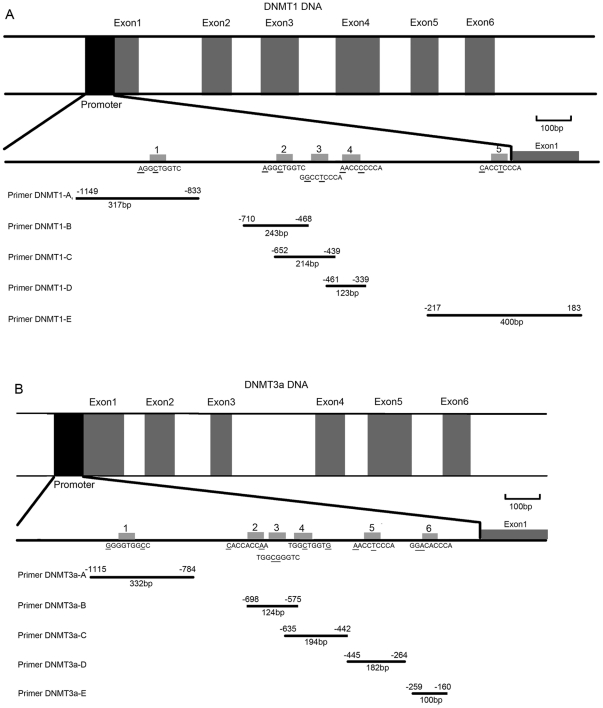
Potential GLI1 binding sites on the DNMT1's and DNMT3a's promoter.Two parallel lines on top of the figure represented DNMT1 or DNMT3a DNA, respectively(A, B), within which gray frames represented exons, white frames represented introns, and black frames represented promoter. In the promoter, small gray frames marked with number 1 to 5 (A) or 1 to 6 (B) represented the potential GLI1 binding sites, which has only two nucleotides difference (underlined) from GLI1 consensus binding sequence, GACCACCCA. Primers were designed to amplify the DNMT1 (A) or DNMT3a (B) promoter region containing the putative GLI1-binding site. The position and length of products amplificated by each primer were shown.